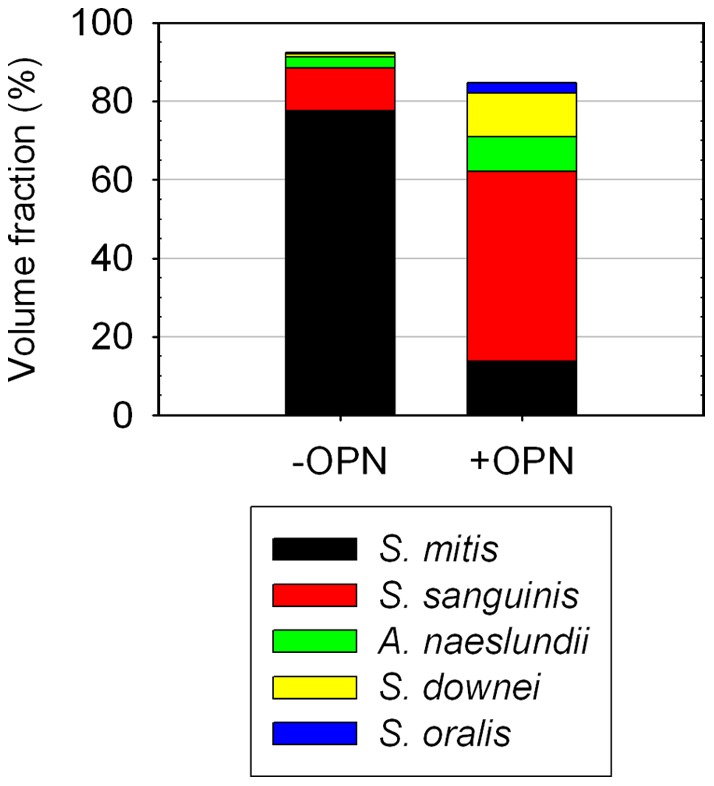
Bacterial composition of biofilms grown in the presence and absence of OPN.In biofilms grown without OPN (−OPN), S. mitis SK24 was the predominant organism. When OPN was present in the medium (+OPN), the abundance of S. mitis was dramatically lower, and the relative abundance of all other organisms increased. S. sanguinis SK150 became the predominant organism.